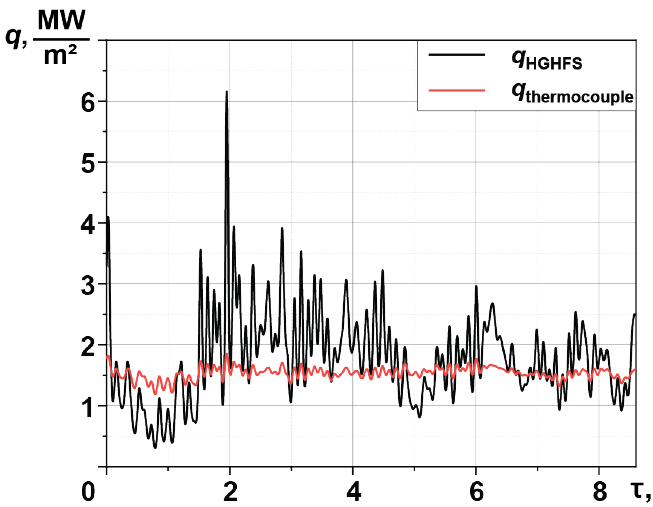
Figure 8. Heat flux graph for pilot studies.